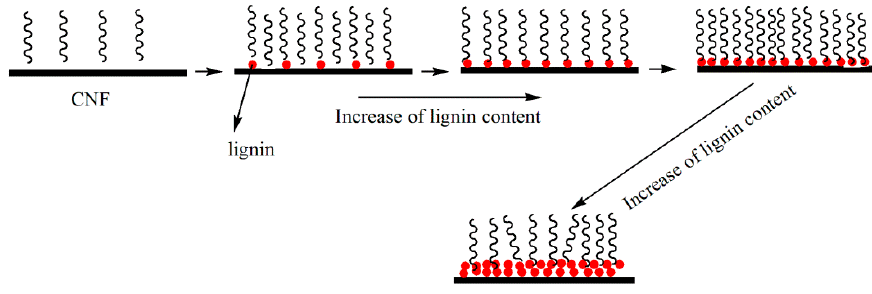
Figure 9. Effect of the lignin content on the compatibility between PLA and the LCNFs.